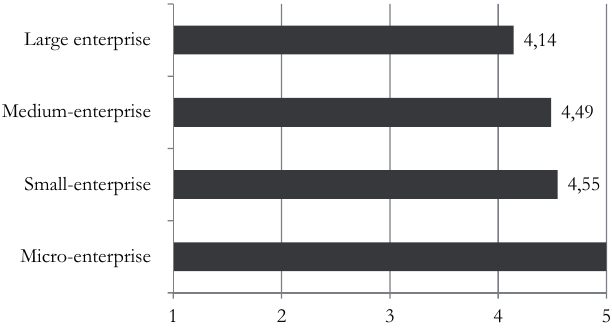
Fig. 1 – Importance of quickness of decision-making in the maintenance of the company’s competitiveness (1-5). Source: own